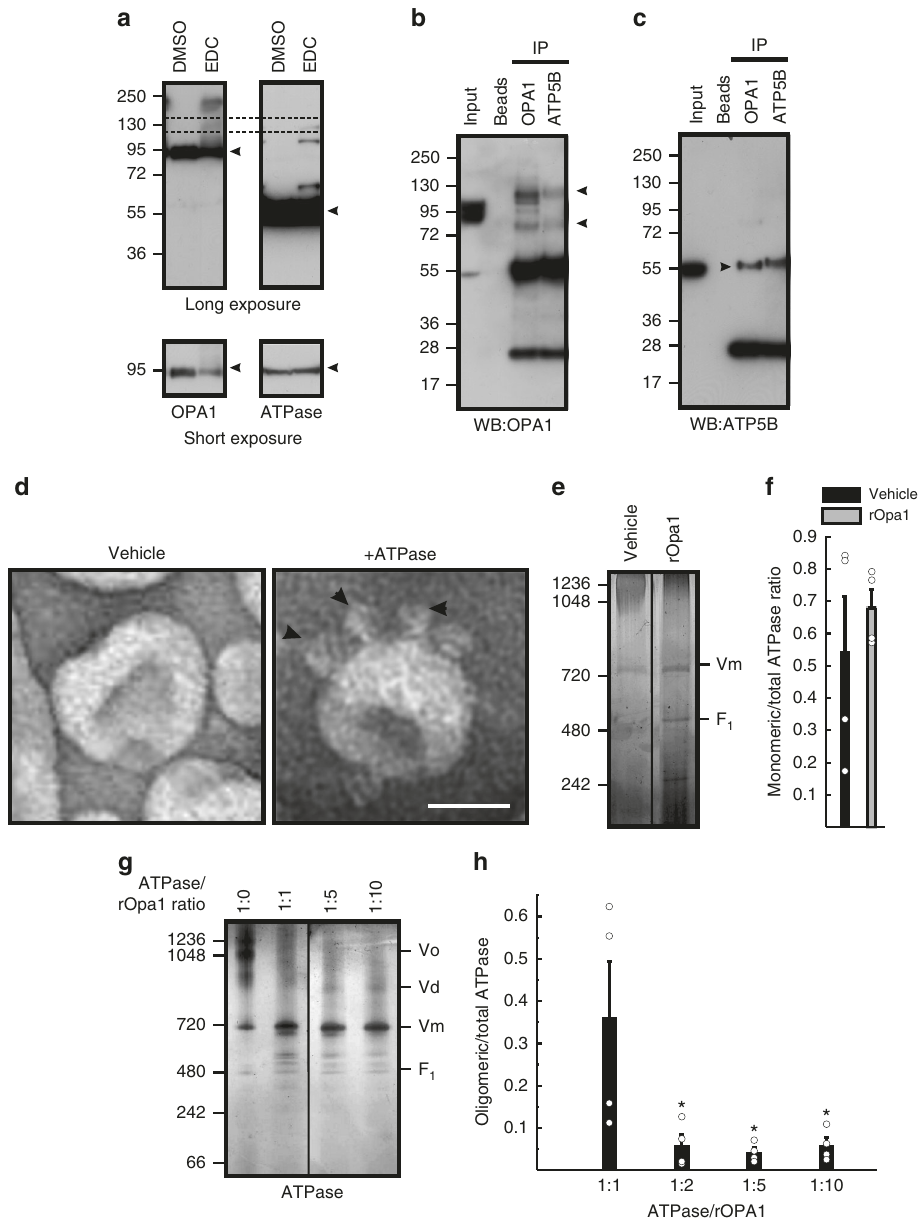
Fig. 5 OPA1 does not directly stimulate ATP synthase oligomerization. a Puri fi ed mitochondria were treated where indicated with 10 mM EDC. After 30 min the reaction was quenched, mitochondria lysed and equal amounts (40 µ g) of proteins were separated by SDS-PAGE and immunoblotted using the indicated antibodies. Dashed box: OPA1 and ATPase cross-reactive adduct. Arrowheads: non-crosslinked OPA1 and ATPase. Bottom panels: short exposure blots of non-crosslinked OPA1 and ATPase. b , c Mitochondrial lysates (200 µ g) were immunoprecipitated with the indicated antibodies coupled to Protein A agarose beads; bound proteins were separated by SDS-PAGE and immunoblotted using the indicated antibodies. Input was diluted 1:10. d Representative EM image of a negatively stained proteoliposome containing rOPA1 in the lumen either in the absence (left panel) or presence (right panel) of recombinant ATP synthase in the membrane. Arrowheads: F 1 oriented towards the outside of the liposome. Scale bar, 50 nm. e Proteoliposomes harboring ATPase and either empty or containing rOpa1 were solubilized and proteins separated by BN-PAGE. f Densitometric quanti fi cation of ATPase composition in experiments as in e . Data are mean ± SEM of four independent experiments. g , h Representative BNGE ( g ) and densitometric quanti fi cation ( h ) of ATPase oligomeric forms upon incubation of the indicated ratios of rOPA1 with ATP synthase (3 µ g). Data are mean ± SEM of four independent experiments. Vo: ATPase oligomers, Vd: dimers, Vm: monomers